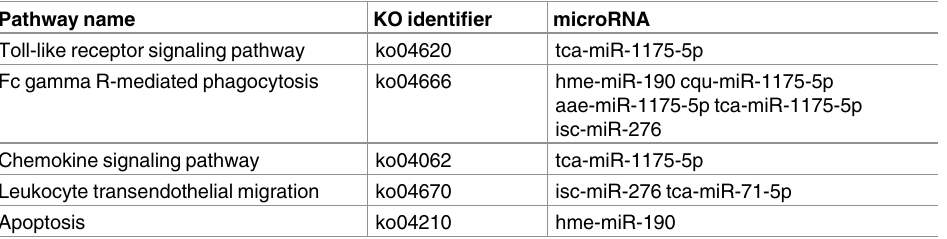
Table 1. The immune pathways—Related microRNAof Sarcoptes scabiei